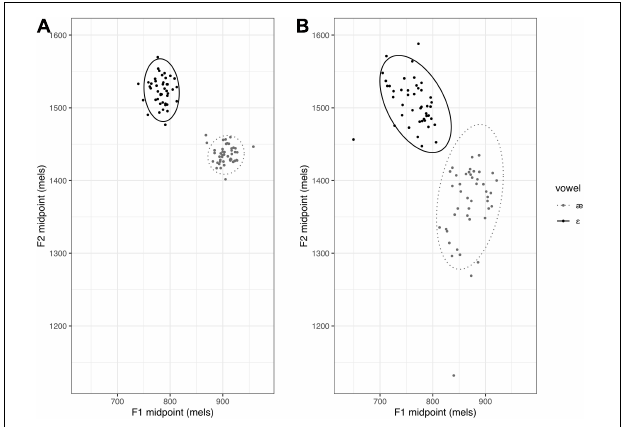
FIGURE 2 | Examples illustrating area of the ellipse. Panel (A) represents a participant with small average area of the ellipse and panel (B) represents a participant with large average area of the